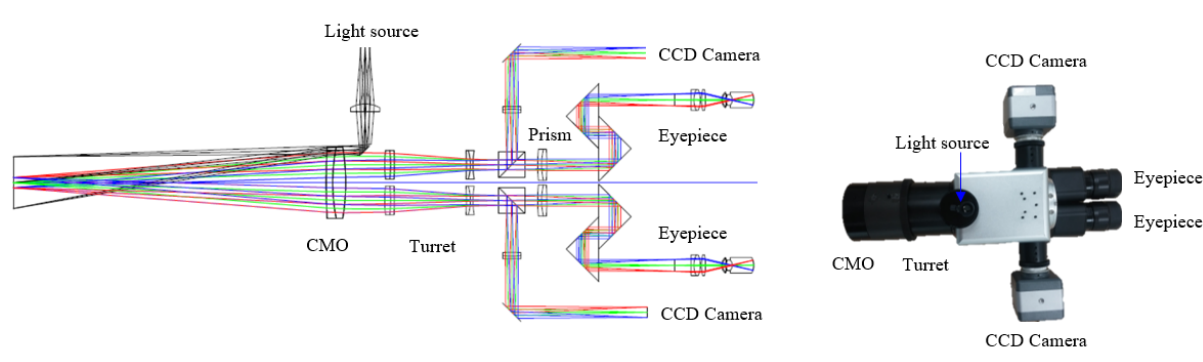
Figure 2. Left: optical design of the stereoscopic microscope; right: picture of the fabricated stereoscopic microscope. CCTV: closed-circuit television; CCD: charge-coupled device; CMO: common main